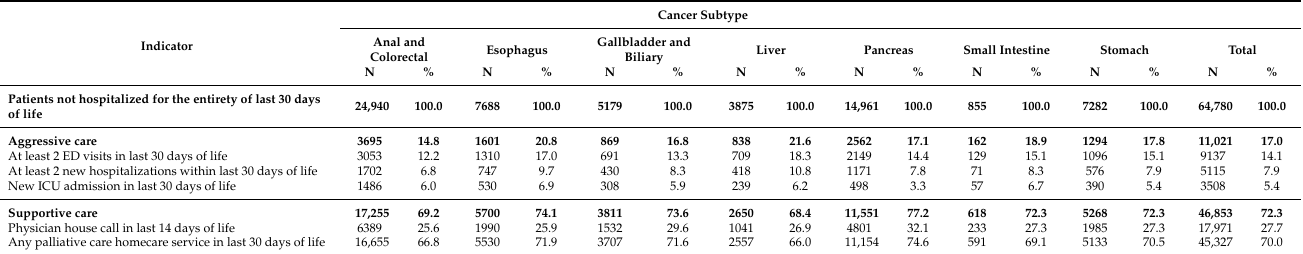
Table 3. Quality indicator aggregates by GI malignancy